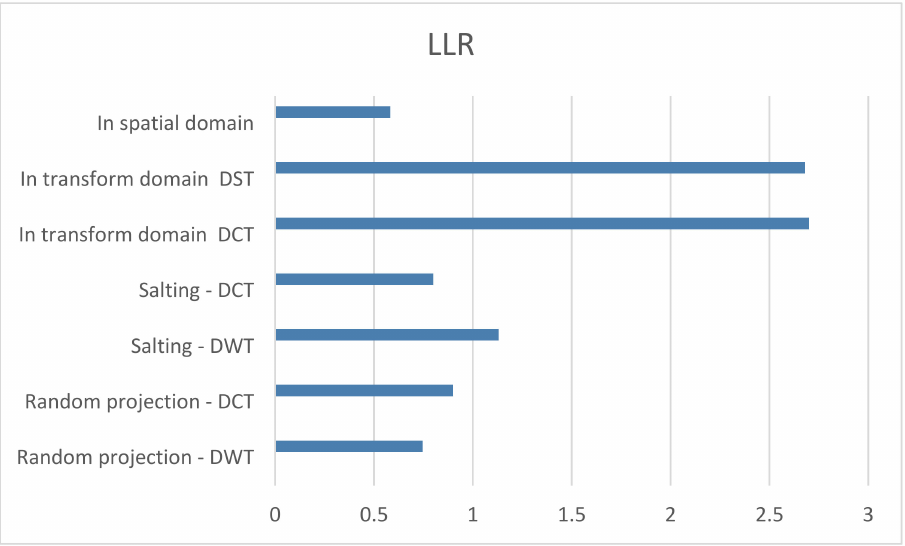
Figure 8. Comparison of LLR values for the proposed